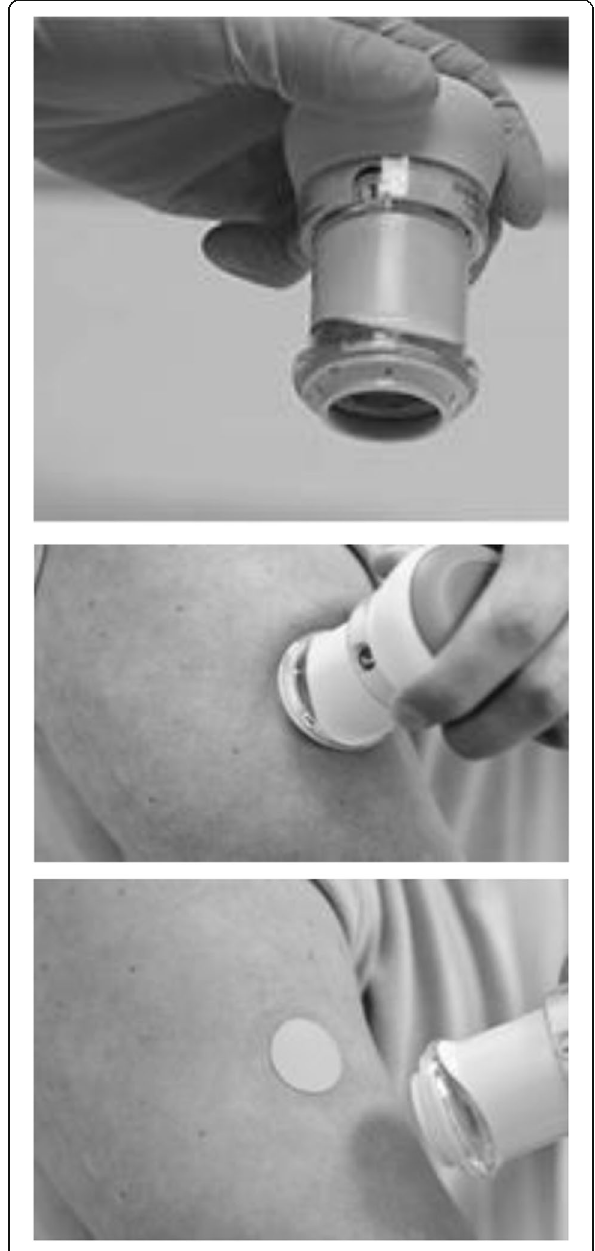
Fig. 1 M207 system for zolmitriptan delivery. Table adapted from Reference [1], published under CC BY-NC-ND